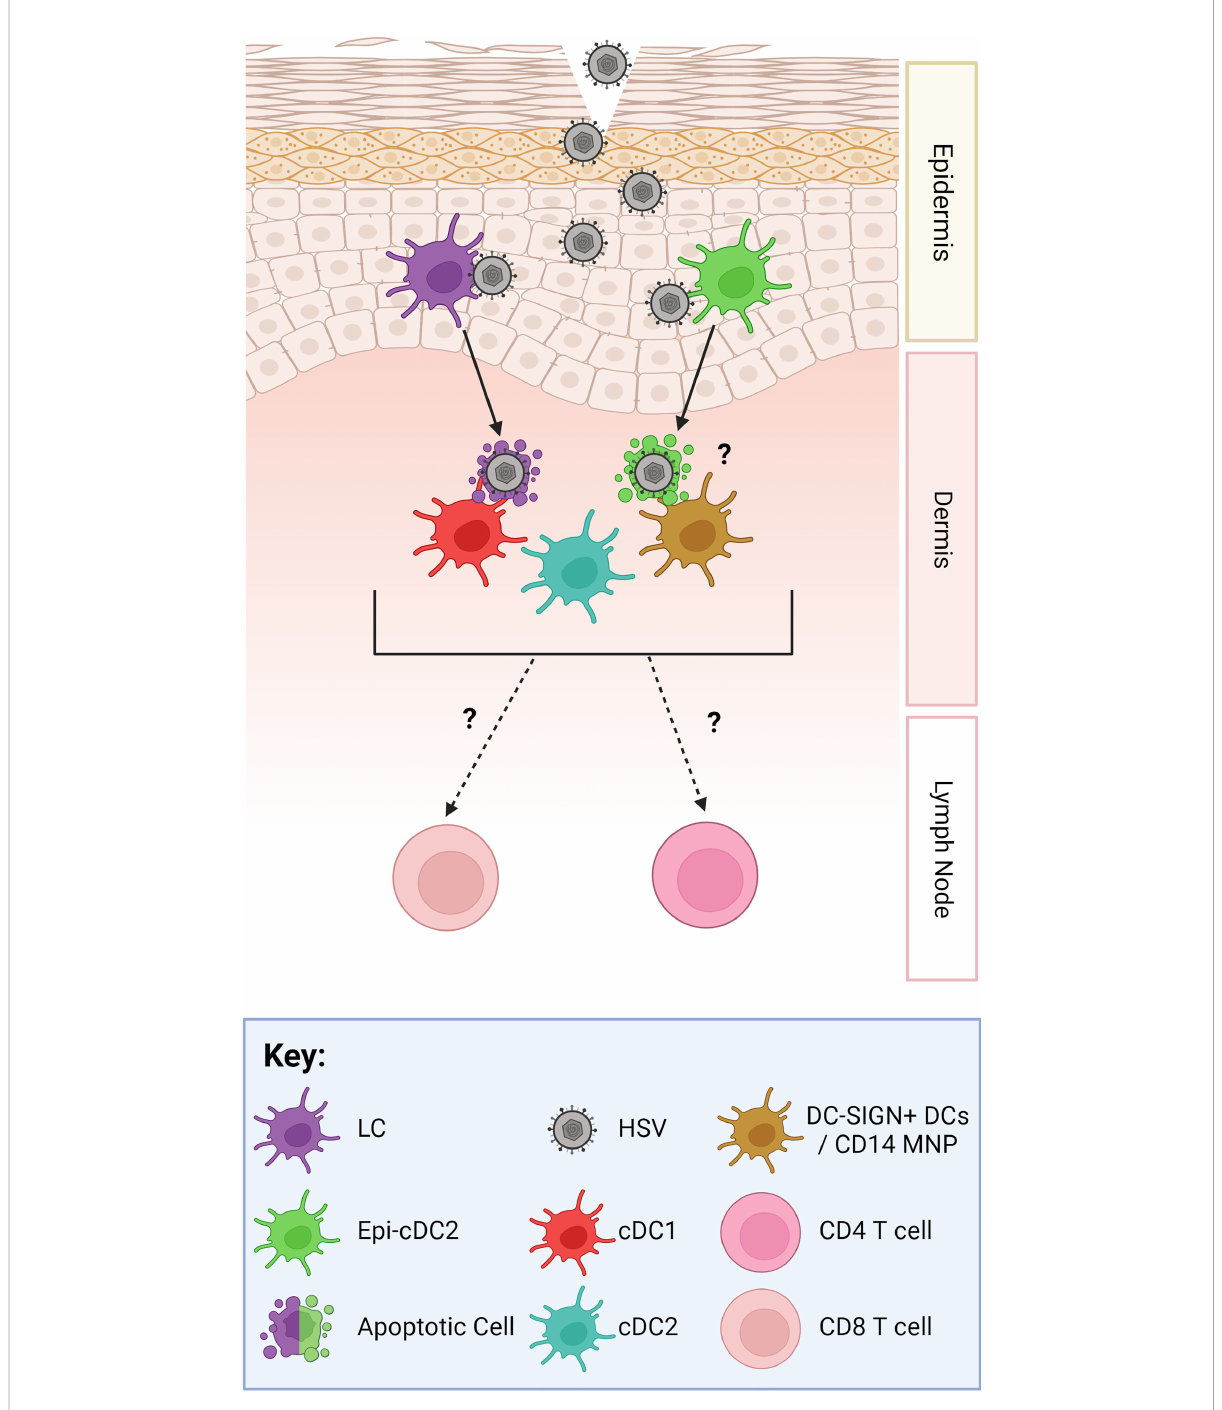
FIGURE 1 The Human HSV Viral Relay. As HSV gains access to the epidermis, hypothesised through micro-abrasions, it infects LCs (purple) and Epi-cDC2s (green). LCs then migrate down into the dermis, undergo apoptosis, and cluster with and are taken up by dermal DCs, such as cDC1s (red) and DC-SIGN + DCs/macrophages which are termed CD14 MNPs (mononuclear phagocytes) (orange) (9). Dermal cDC2s (blue) have not yet been shown to cluster with LCs. Epi-cDC2s have been shown to undergo apoptosis but whether they cluster with the dermal DCs is yet to be shown. Subsets of murine dermal DCs carry HSV antigen out of the dermis and have been shown to present the HSV antigen to CD4 and CD8 T cells in the lymph node (10 – 12). However, this has not yet been shown in human